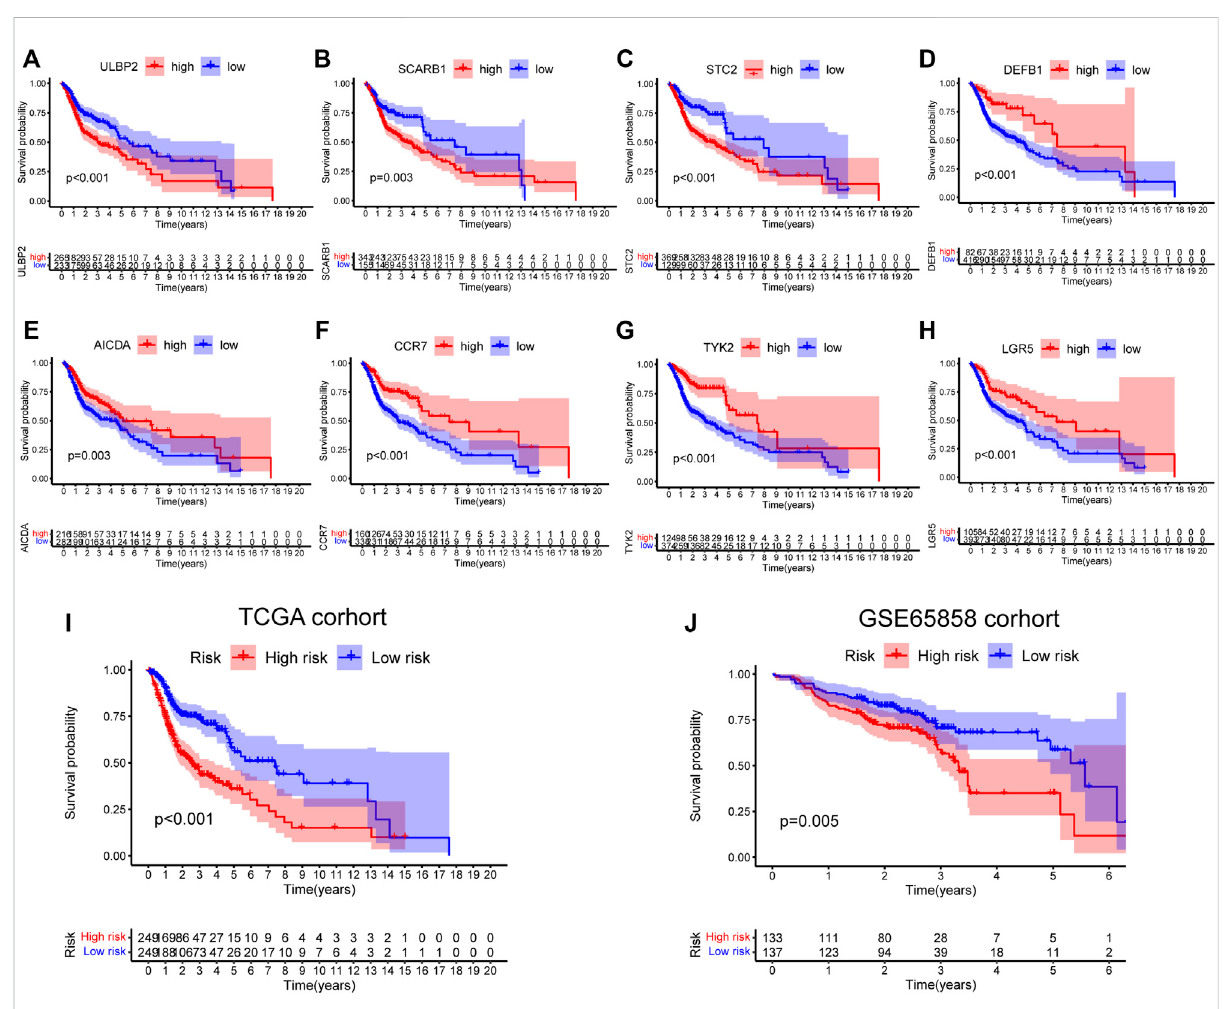
FIGURE 6 Survival analysis of eight genes in risk signature. (A) ULBP2: p < 0.001. (B) SCARB1: p = 0.003. (C) STC2: p < 0.001. (D) DEFB1: p < 0.001. (E) AICDA: p =0.003. (F) CCR7: p < 0.001. (G) TYK2: p < 0.001. (H) LGR5: p < 0.001. (I,J) Survivalanalysisofthe8-genesignatureinTCGA( p < 0.001)and GSE65858 cohorts ( p =